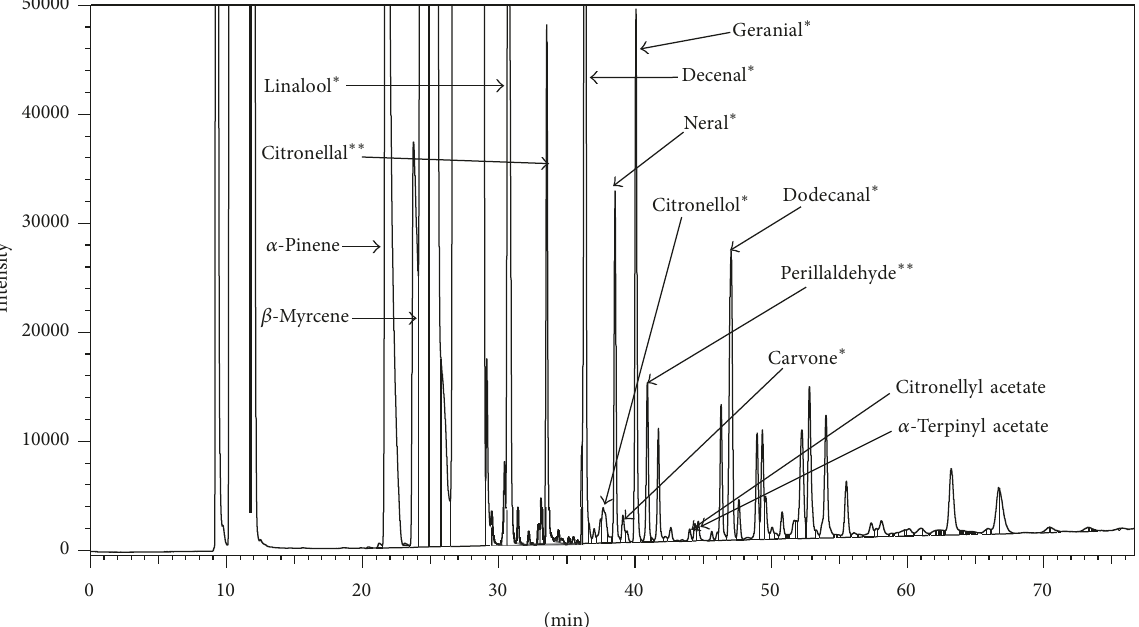
Figure 8: Chromatogram from Valencia Late Symptomatic. Note . While 2-decenal and 2,4-decadienal were quantifiable in this sample, they were not labeled on the chromatogram as the peaks are too small to be seen. ∗ Compound has lower concentration compared to VLA. ∗∗ Compound has higher concentration compared to